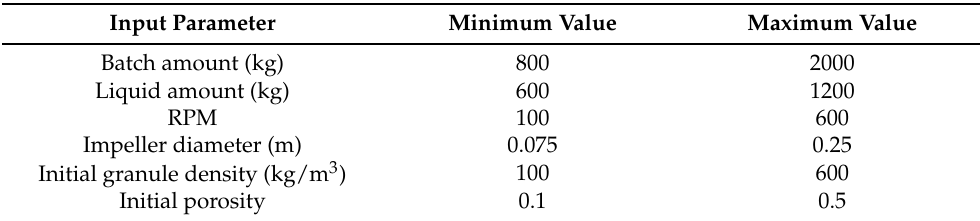
Table 1. Bounds chosen for the input variables sensitivity analysis.